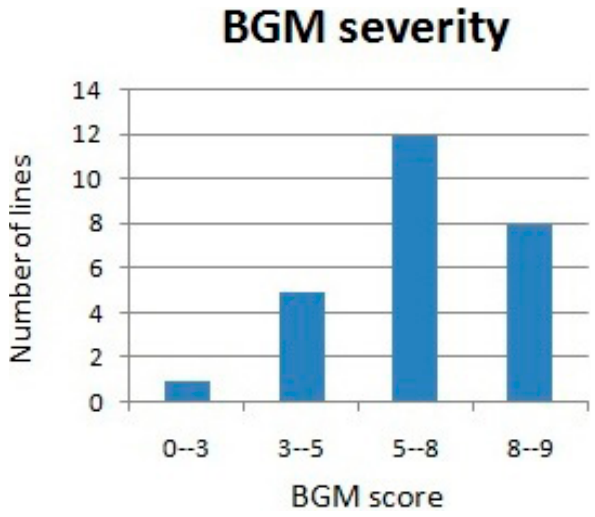
Figure 3. Frequency distribution of BGM scores of all wild Cicer spp. screened under field and laboratory conditions.